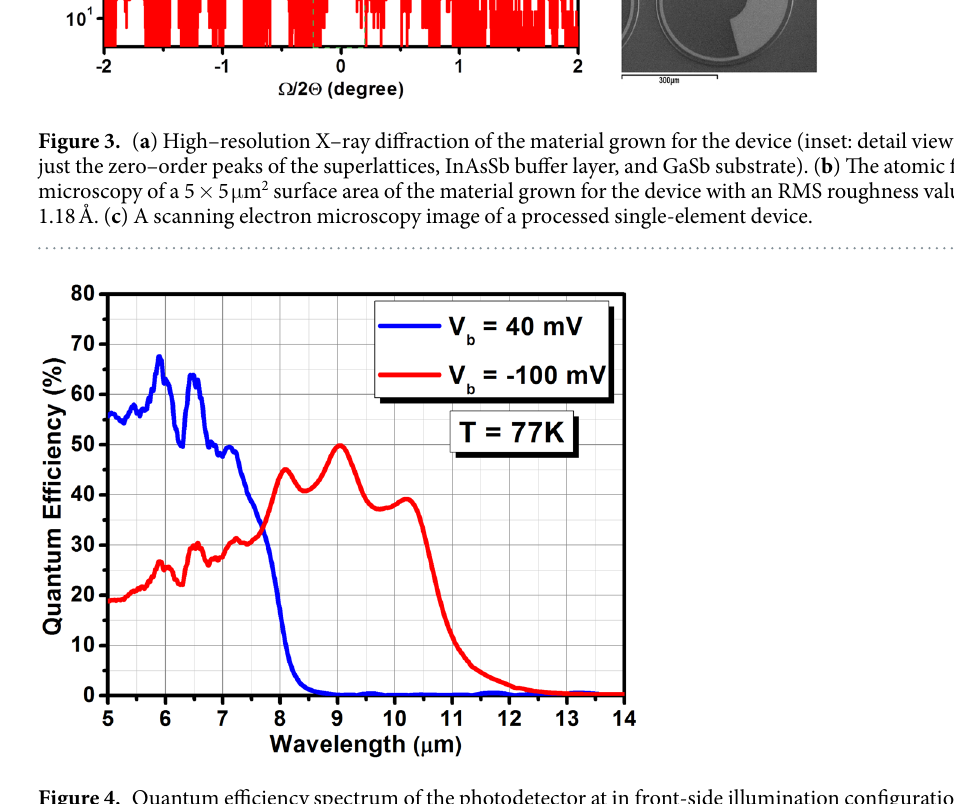
Figure 4. Quantum efficiency spectrum of the photodetector at in front-side illumination configuration without any anti-reflection coating at 77 K. The devices acts like a LWIR (blue) photodetector at + 40 mV applied bias and a VLWIR (red) photodetector − 100 mV bias